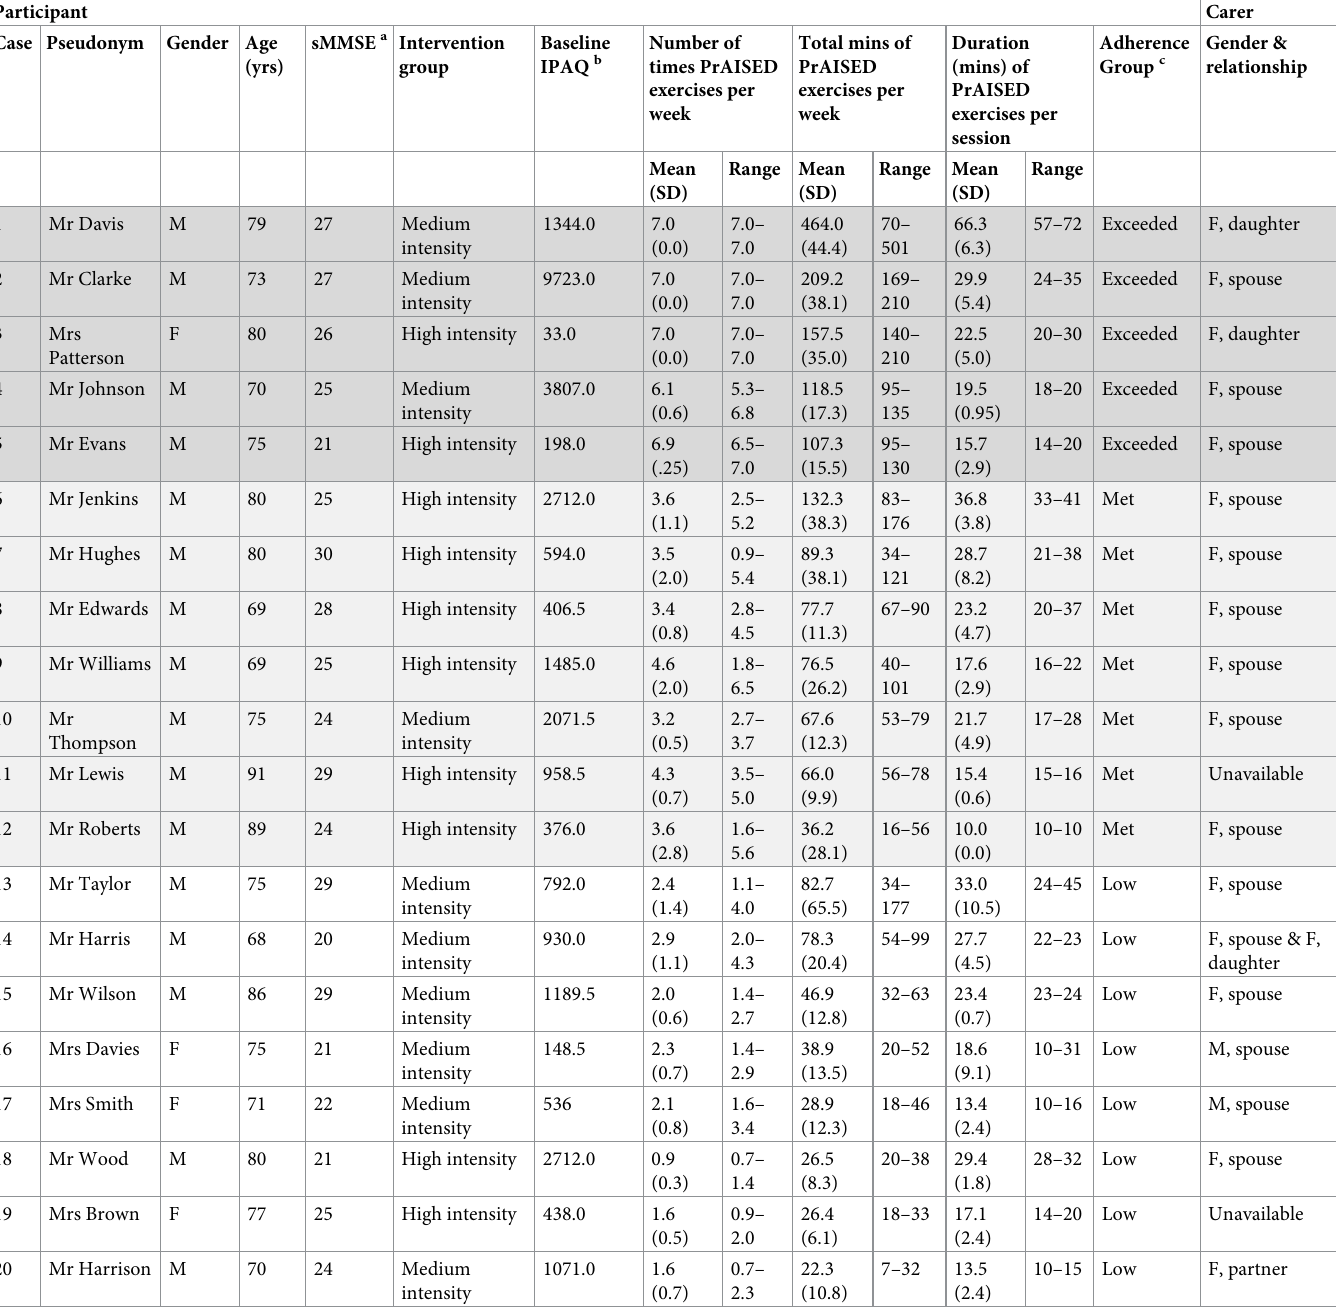
Table 1. Sample characteristics and adherence grouped based on number of PrAISED exercise sessions per